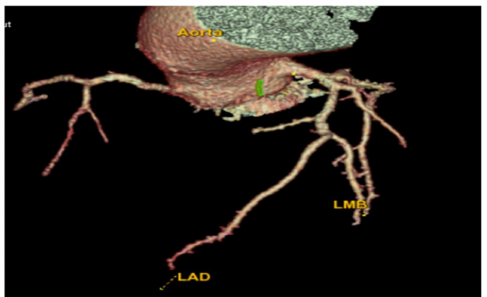
Figure 13. Computed tomography: 3-D reconstruction of the ascending aorta along with the three coronary arteries: left anterior descending (LAD), left marginal branch